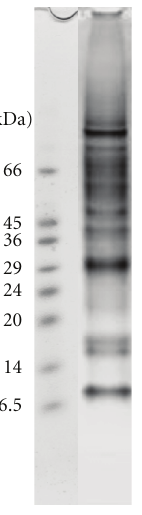
Figure 2: 4–12% SDS-PAGE of the fractions collected from the immunoa ffi nity chromatography of the normal mouse brain homogenate. Lane 1: Markers, Lane 2: fractions collected with 3 M NaSCN, 10mM MOPS, pH